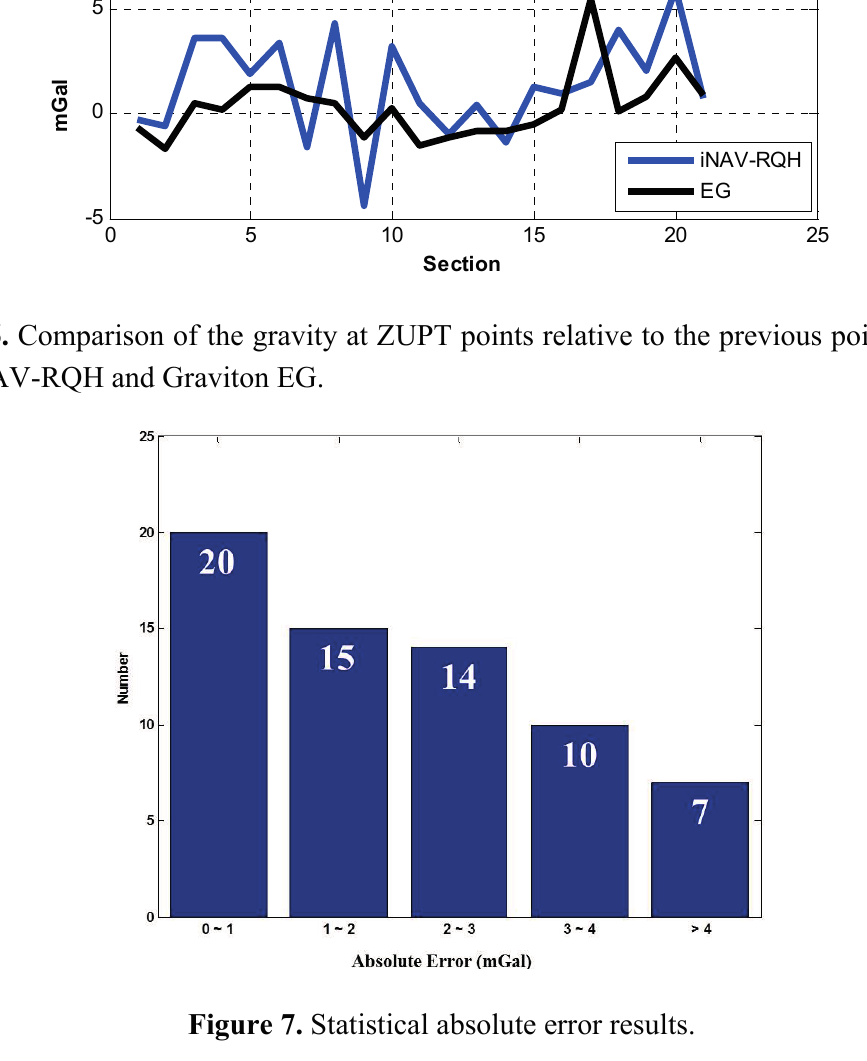
Figure 7. Statistical absolute error